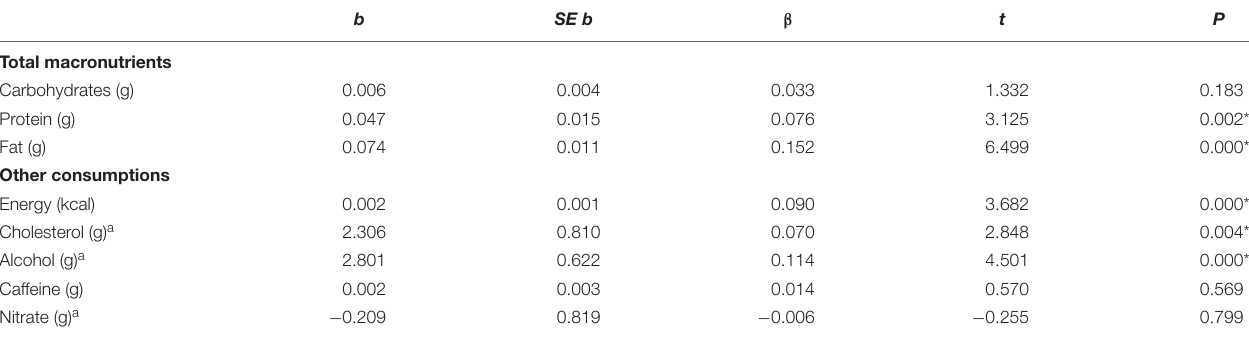
TABLE 2 | Linear regressions between each nutrient and recollection accuracy (%).